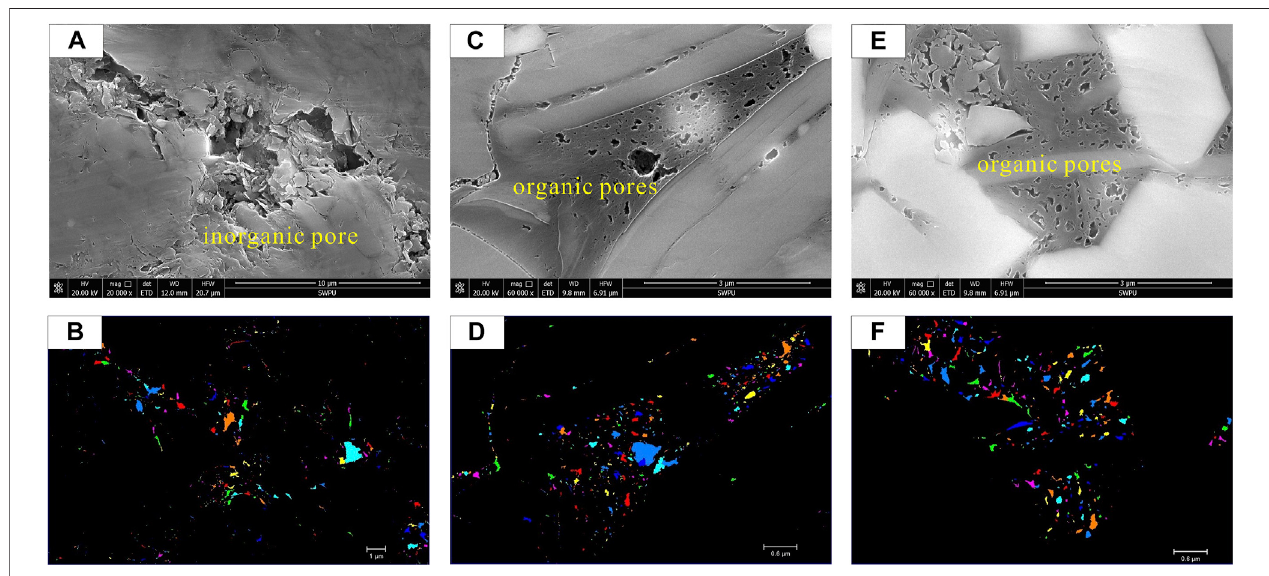
FIGURE 7 | Microphotographs showing main pore types and distribution characteristics of shale reservoir. (A) Inorganic pores, 3939.25 m, L206 well; (B) pore morphology and distribution of graph a; (C) organic pores and grain boundary pores, 3967.62 m, L206 well; (D) pore morphology and distribution of graph c; (E) pyrite intercrystalline pores and organic pores between pyrite crystals, 3980.96 m, L206 well; (F) pore morphology and distribution of graph (E) .